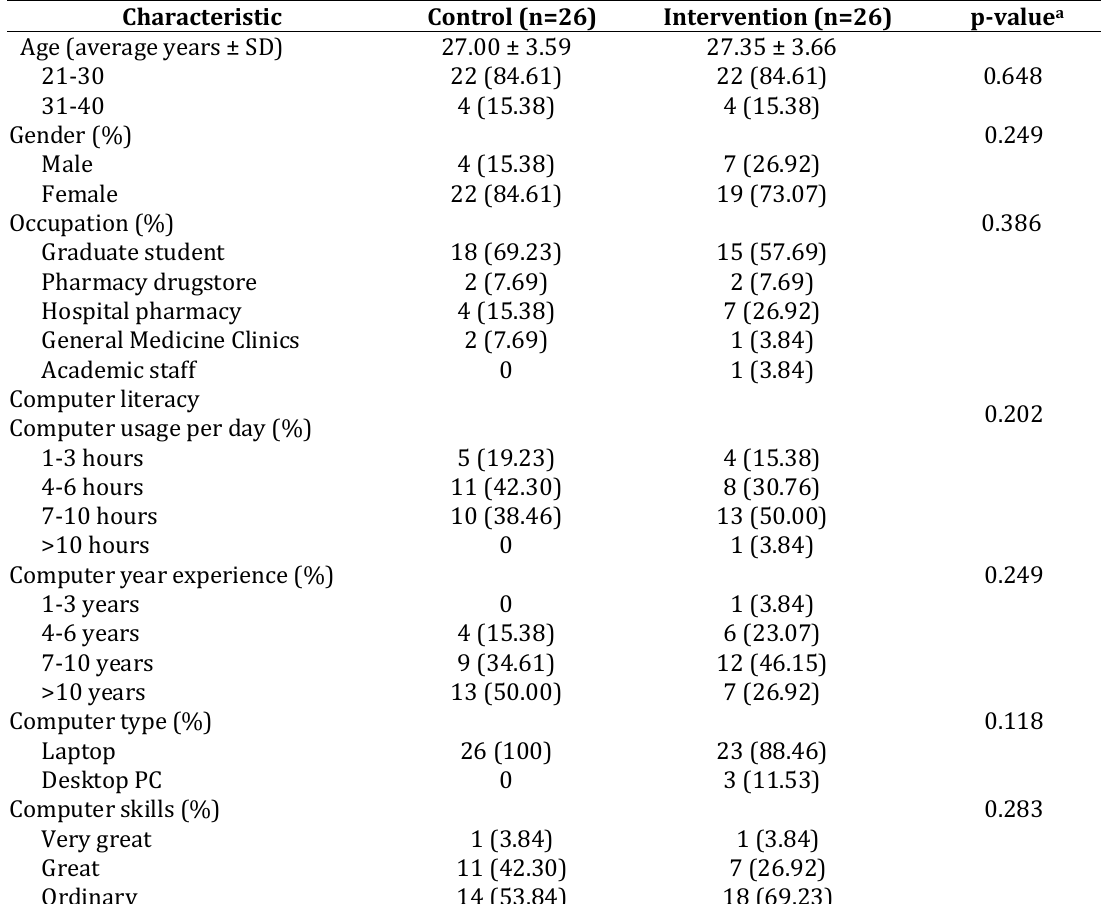
Table I. Characteristics of pharmacists involve in the study Characteristic